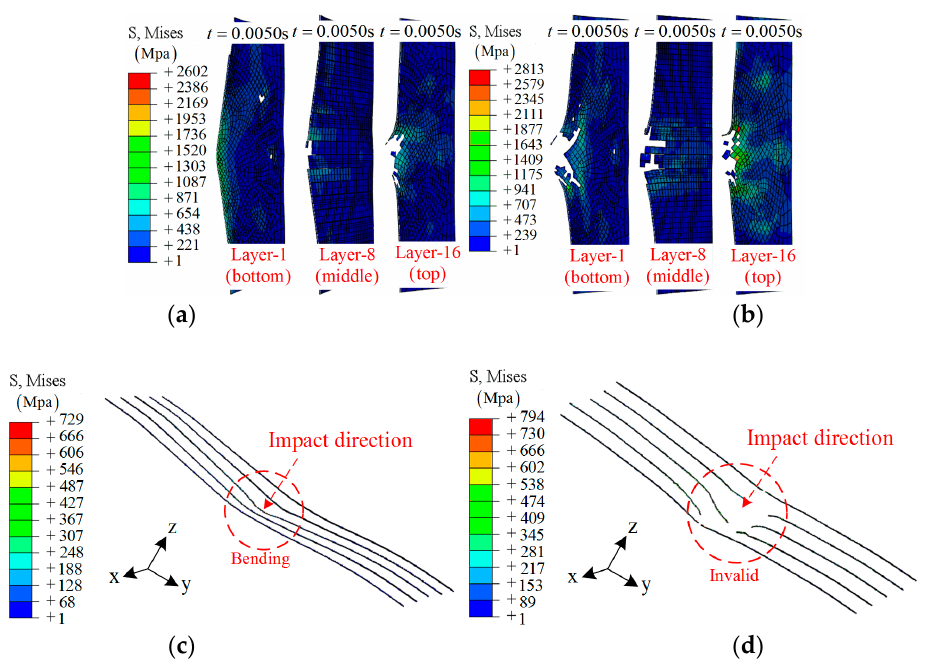
Figure 8. The middle section of different layers during the impact: ( a ) layers in group A3; ( b ) layers in group A4; ( c ) the SMA in group A3; ( d ) the SMA in group A4.